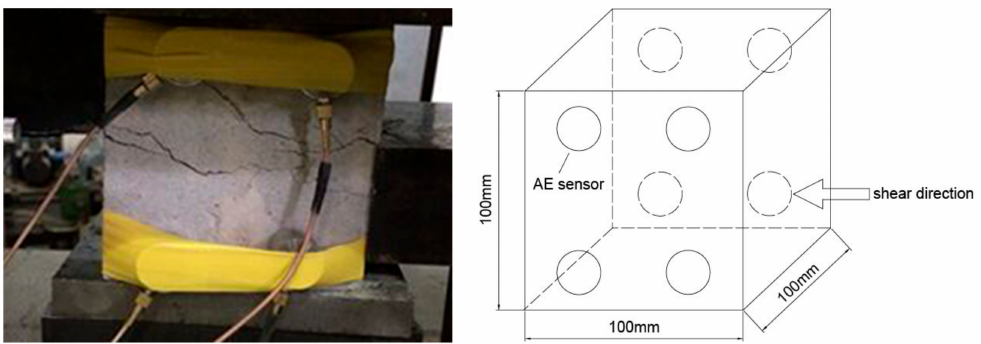
Figure 8. Location of the acoustic emission (AE) sensors.